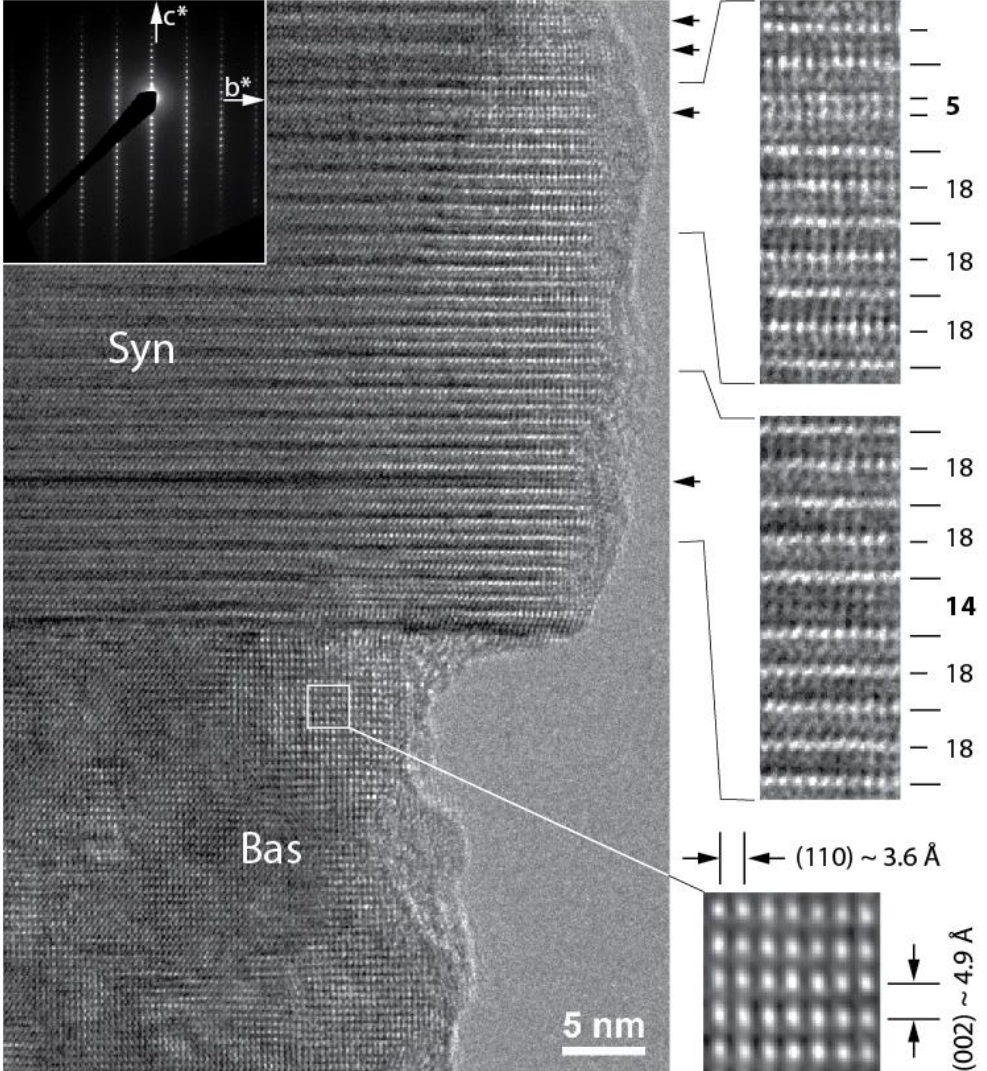
Figure 10. [100] HRTEM image of synchysite (Syn) with an overgrowth of bastnäsite (Bas) along with the SAED pattern of synchysite (inset). According to the high resolution image (enlarged filtered image of the squared region in the lower right side) bastnäsite is oriented along [110]. Synchysite shows some polysomatic faults (arrows). The measured ~14.1 Å width is consistent with a VBB lamella within VBVB synchysite (~18.3 Å). The narrow faults present in the upper region measure ~4.9 Å, which is consistent with an extra B -layer within VBVB synchysite, therefore also these faults correspond to VBB sequences within synchysite (for explanation see text).